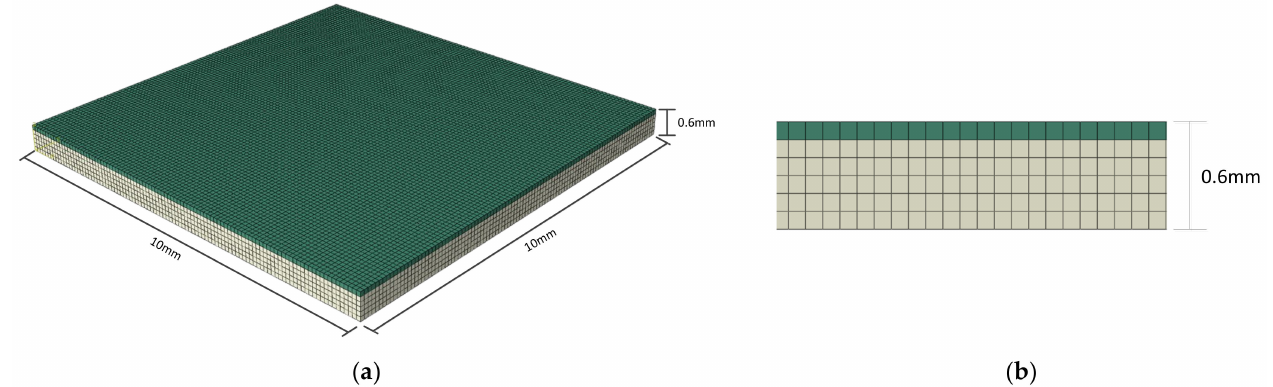
Figure 3. Finite element model and mesh division of laser cleaning sample. ( a ) three-dimensional mesh, ( b ) two-dimensional mesh.